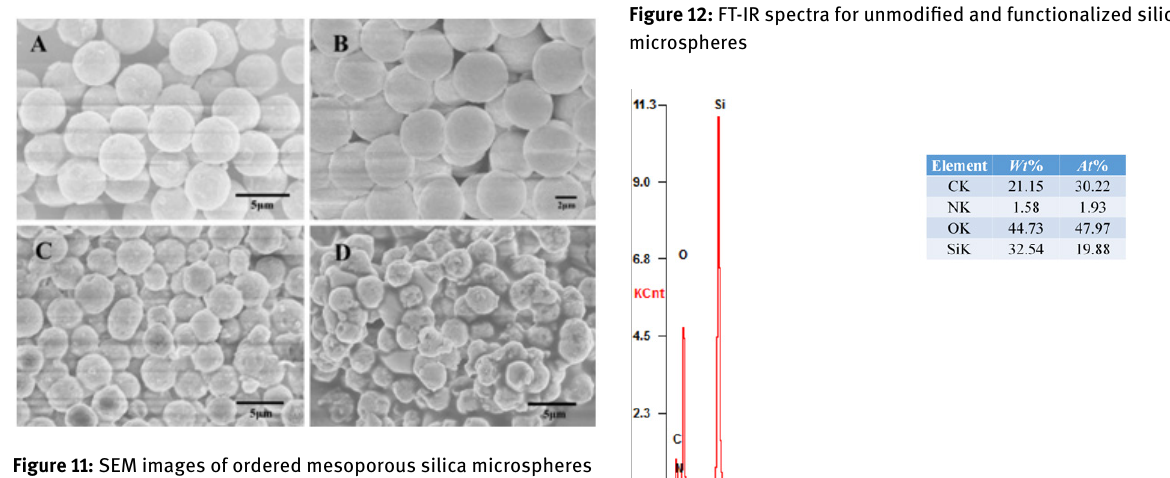
Figure 11: SEM images of ordered mesoporous silica microspheres prepared under different temperature, (A) 100 ∘ C (B) 125 ∘ C (C) 150 ∘ C